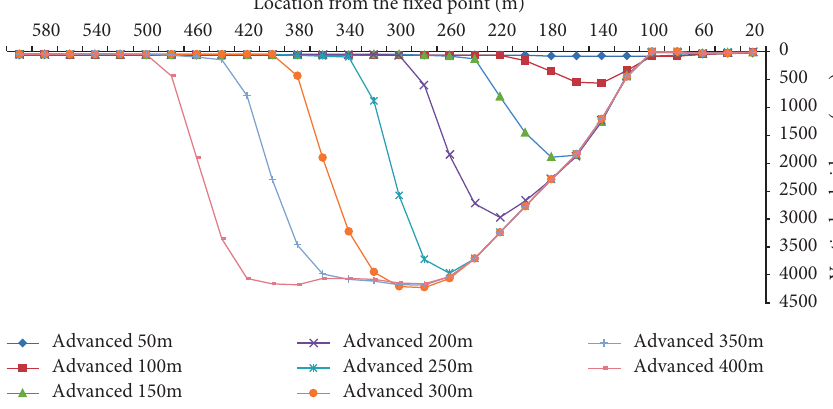
Figure 16: Surface subsidence curve.